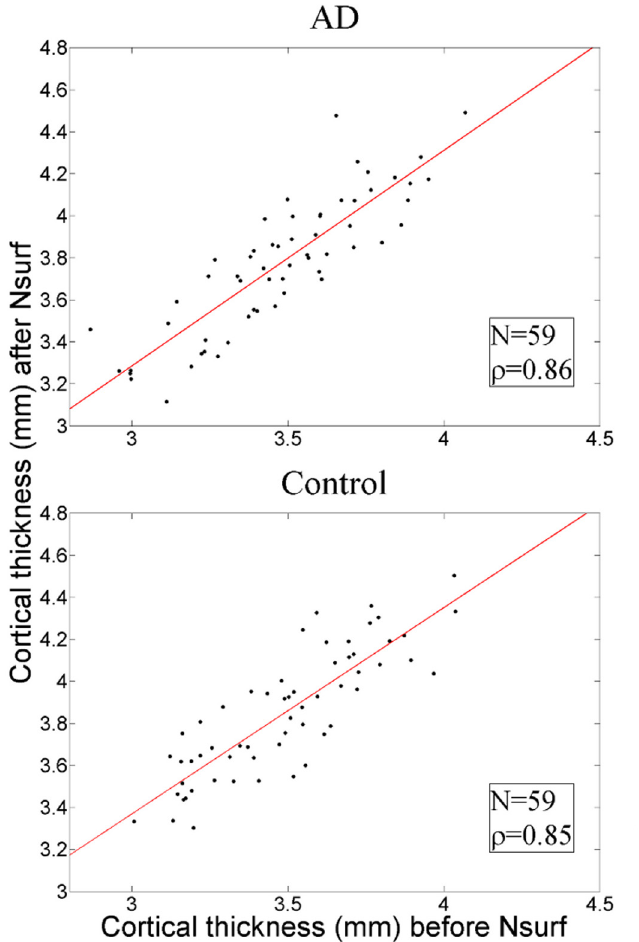
Fig 4. Cortical thickness before and after nonlinear surface (Nsurf) registration in AD subjects (top panel) and the matched control subjects (bottom panel). Cortical thickness was increased to the same level in both groups (as expected given the slightly larger standard space) and therefore Nsurf did not create a bias that would influence subsequent